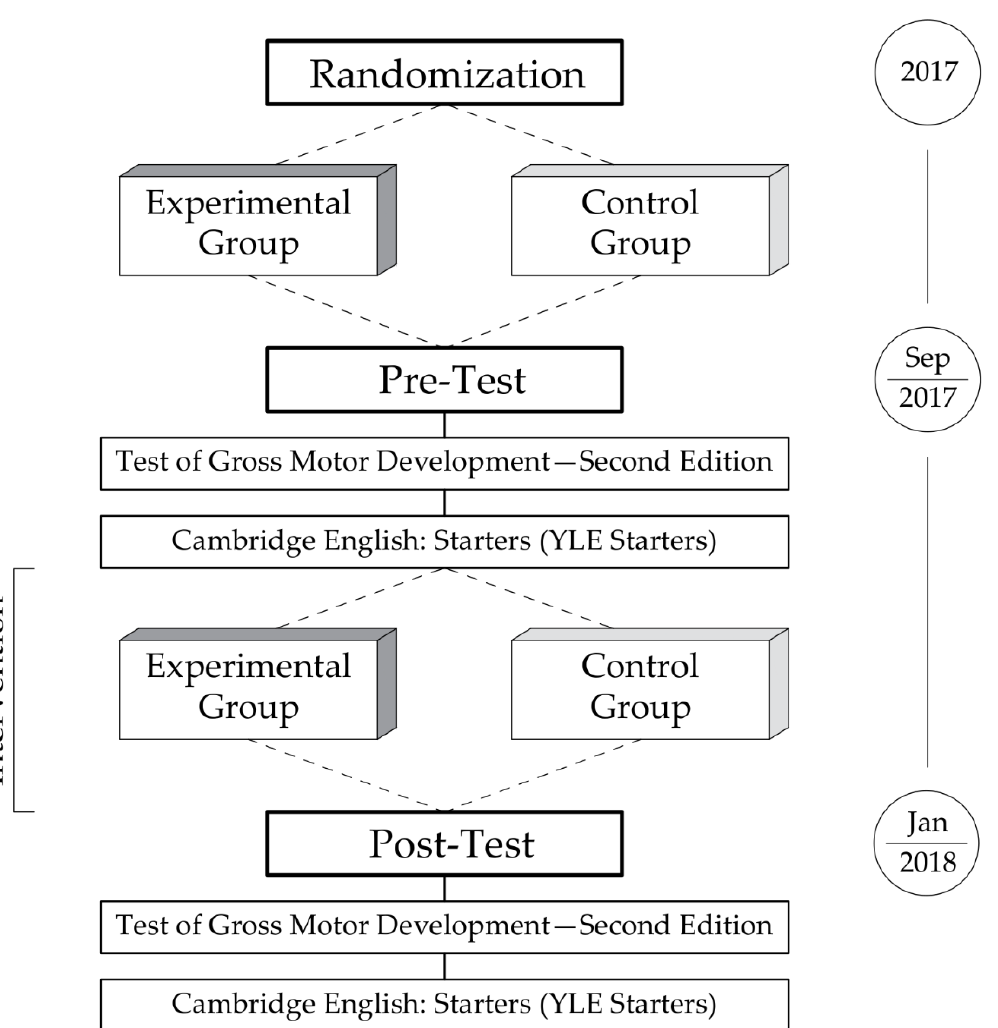
Figure 2. The experimental workflow. Classes were randomly assigned into experimental and control groups. Pre-test and post-test ware carried out in the same order: (1) Test of Gross Motor Development (Edition #2) and (2) Cambridge English: Starters (Pre A1 Starters).